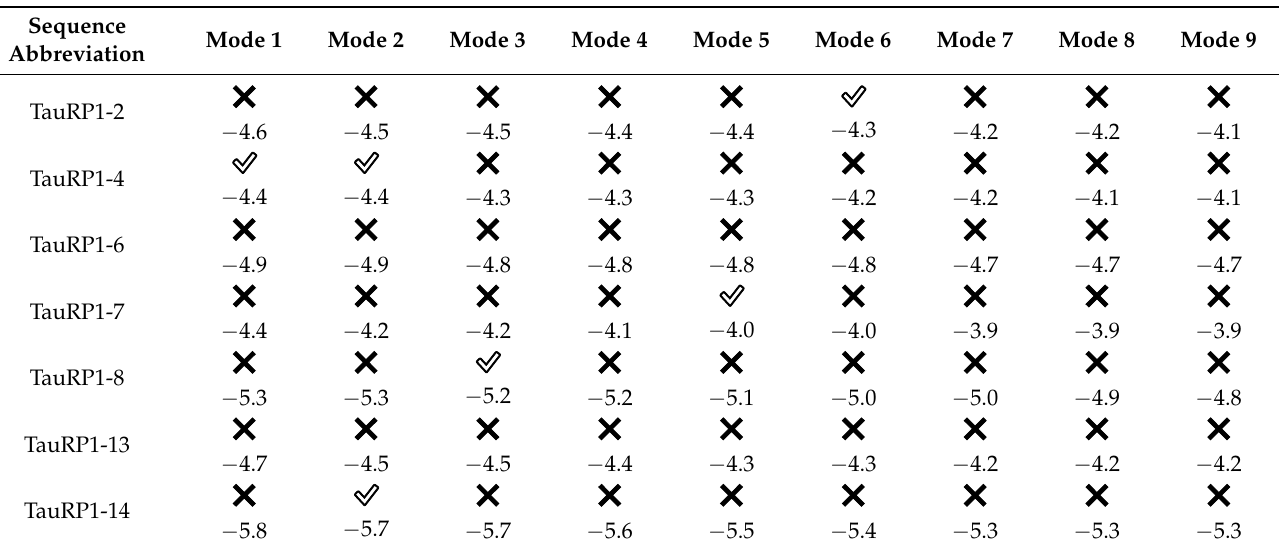
❌ indicates that peptide was found outside the LRP1 binding pocket. ✅ indicates modes where the peptide bound within the predicted binding pocket. 3.4.2. Docking Studies with Additional Ligands Implicated in Alzheimer’s Disease